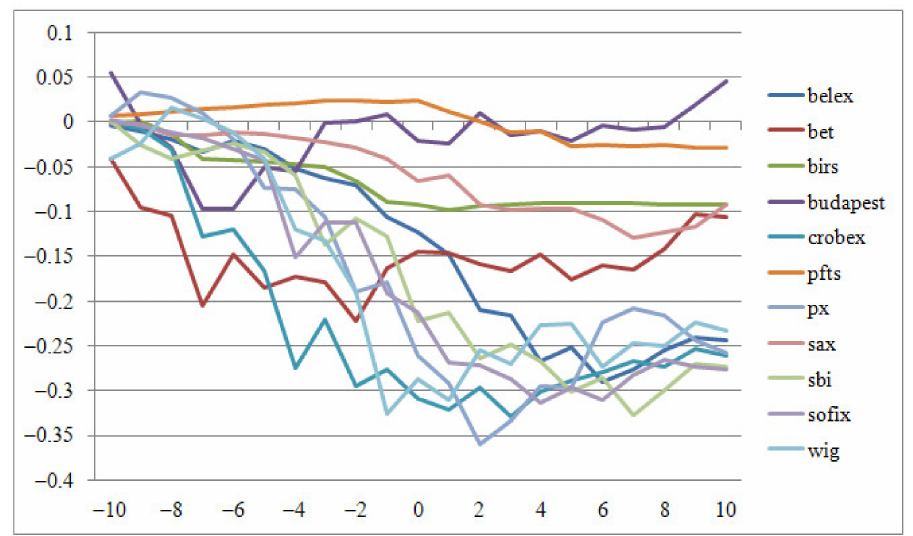
Figure 4. CARs for all countries, event 5.